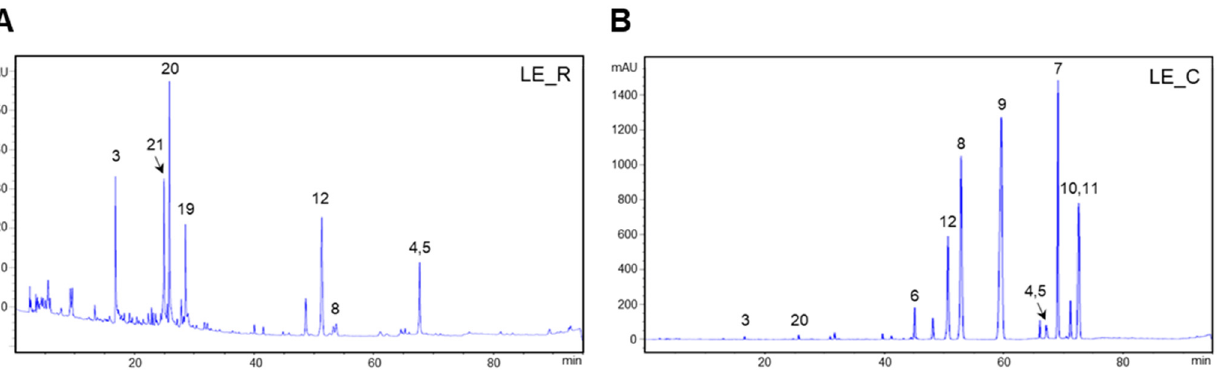
Figure 1. HPLC chromatogram of L. erythrorhizon extracts derived from the cold and heat extraction procedures. ( A ) LE_R, 95% ethanol reflux extraction at 70 °C. ( B ) LE_C, 95% ethanol extraction at room temperature. (3) N,N ′ -dicoumaroylspermidine, (4) anhydroalkannin, (5) deoxyshikonin, (6) shikonin, (7) isobutyrylshikonin, (8) β -hydroxyisovalerylshikonin, (9) acetylshikonin, (10) α -methylbutyrylshikonin, (11) isovalerylshikonin, (12) shikonofuran E, (19) salvianolic acid A, (20) lithospermic acid, and (21) rosmarinic acid.